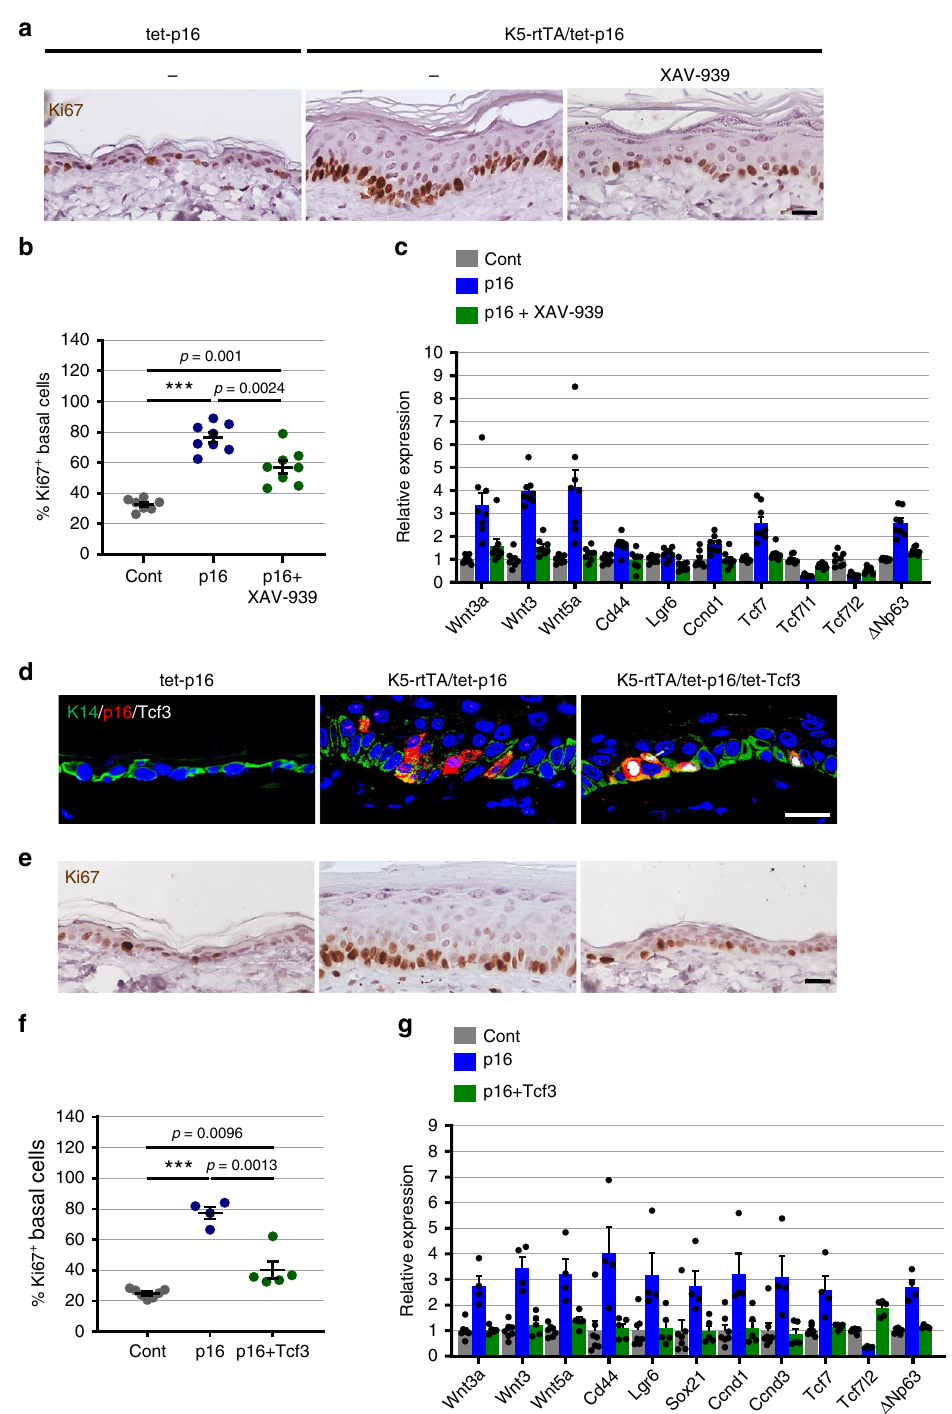
Fig. 6 Wnt activity mediates p16-induced epidermal hyperplasia. a Skin sections from control tet-p16 mice (left) and K5-rtTA/tet-p16 mice treated with dox for 6 months, and subsequently treated for 1 week with XAV-939 (right) or with vehicle (middle), stained for Ki67 (brown). b Percentage of Ki67 + basal IFE cells in sections from same mice (dots). n = 7, 8, 8, combined from two independent experiments. c Relative mRNA levels of the indicated Wnt- associated genes in isolated epidermis from the same mice, measured by qRT-PCR. n = 8 mice per group. P < 0.05 for all comparisons between p16- expressing mice (blue) and XAV-939-treated mice (green). d Skin sections from control (tet-p16), K5-rtTA/tet-p16 and K5-rtTA/tet-p16/tet-Tcf3 mice treated with dox for 6 months, stained for p16 (red) and Tcf3 (white). e Skin sections from the same mice as in d stained for Ki67 (brown). f Percentage of Ki67 + basal IFE cells in mice expressing p16 (p16) or p16 together with Tcf3 (p16 + Tcf3) for 6 months, and from controls (Cont). n = 7, 4, 5. g Relative mRNA levels of the indicated Wnt-associated genes in isolated epidermis from the same mice, measured by qRT-PCR. n = 7, 4, 5. Scores were done visually from images. All graphs indicate mean values across mice ± S.E.M. P < 0.05 for all comparisons between p16-expressing mice (blue) and mice co- expressing p16 and Tcf3 (green). *** P < 0.0001. t test was used for all signi fi cance tests. Scale bars — 20 μ